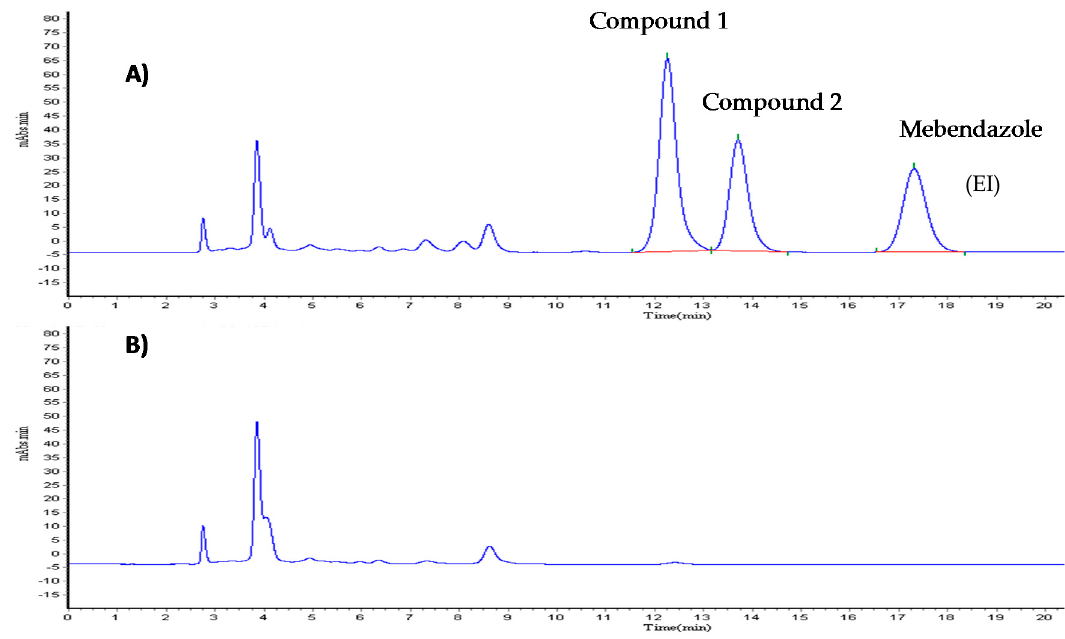
Figure 6. Chromatograms typical of Compound 1 and Compound 2 in rat plasma ( A ) and black of plasm ( B ).